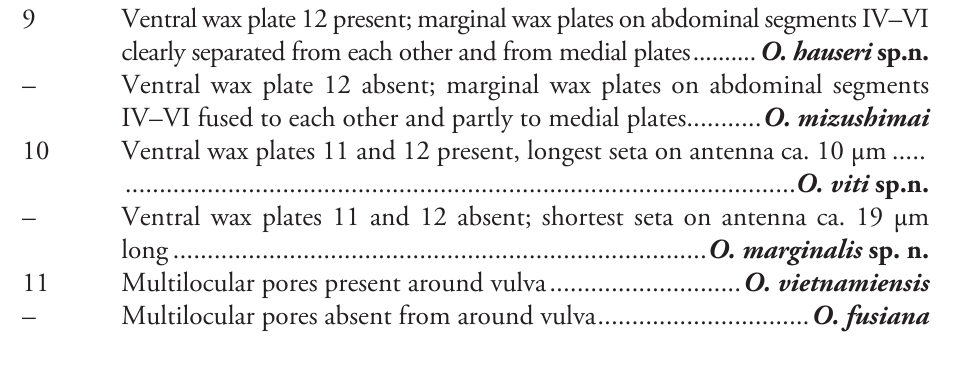
Material examined. Holotype. Adult female. Indonesia, North Sumatra, Prov. Mt. Sibay- ak, 6-7 Jul 2006, Leg. P. Schwendinger [MHNG code: Sum-6/33; PPI code: 9689]. Paratypes. 3 females on one slide: Indonesia, North Sumatra, Tongkoh, 1450 m a.s.l., 3 Dec 1989, Leg. Löbl, Agosti, Bruckhart [MHNG code: N Sum #29a; PPI code: 9678]; 3 females on two slides: Indonesia / North Sumatra, Brastagi, 1500 m a.s.l., 2 Dec 1989, Leg. Löbl, Agosti, Bruckhart [MHNG code: N Sum Nr. 28a; PPI code: 9679]; 1 female: Indonesia, Sumatra, Yambi, Mt. Kerinci, 1750-1850 m a.s.l., 14 Nov 1989, Leg. Löbl, Agosti, Bruckhart [MHNG code: Löbl, Agosti, Bruckhart No. 16; PPI code: 9667]; 1 female: Indonesia, Sumatra, Yambi, Tapan, 1350 m a.s.l., 9 Nov 1989, Leg. Löbl, Agosti, Bruckhart [MHNG code: Leg. Löbl, Agosti, Bruckhart No. 10; PPI code: 9670]; 2 female on one slide: Indonesia, West Sumatra, Lubuksu- lasih, 1100 m a.s.l., 8 Nov 1989, Leg. Löbl, Agosti, Bruckhart [MHNG: W Sum #7; PPI code: 9677]; 1 female: Indonesia, Java, Mt. Gede, 2600 m a.s.l., 5 Nov 1989, Leg. Löbl, Agosti, Bruckhart [MHNG code: W Java #5a; PPI code: 9681]; 4 females on 2 slides: Indonesia, West Java, Cibodas, 25 Nov 1987, Leg. B. Hauser [MHNG: Sar- 87/14; PPI code: 9704]; 7 females on 3 slides: Malaysia / Perak, 21 Nov 1999, Leg. G. Cuccodoro, I. Löbl [MHNG: 13.MALAYSIA; PPI code: 9752]. Description. Unmounted adult female. Not seen. Length of antennal segments: 1 st 70–102 µm; 2 nd 58–82 µm; 3 rd 250–357 µm; 3 rd seg- ment parallel sided or weakly clubbed; apical seta 118–158 µm, subapical seta 36–53 µm; fleshy sensory seta near apical seta 15–22 µm; microseta present near apex of antenna; unusual hair-like seta present near subapical seta; all segments of antennae covered with moderate number of spine-like, straight, apically acute setae, longest seta 22 µm long; first antennal segment with two setae on each side of segment together with several fleshy